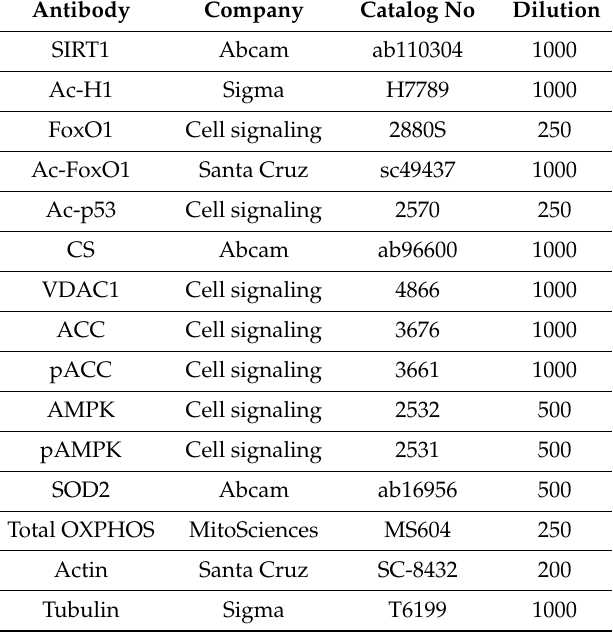
Table 3. Antibodies. SIRT1, sirtuin 1. Ac-H1, acetylated histone 1. FoxO1, forkhead box O protein